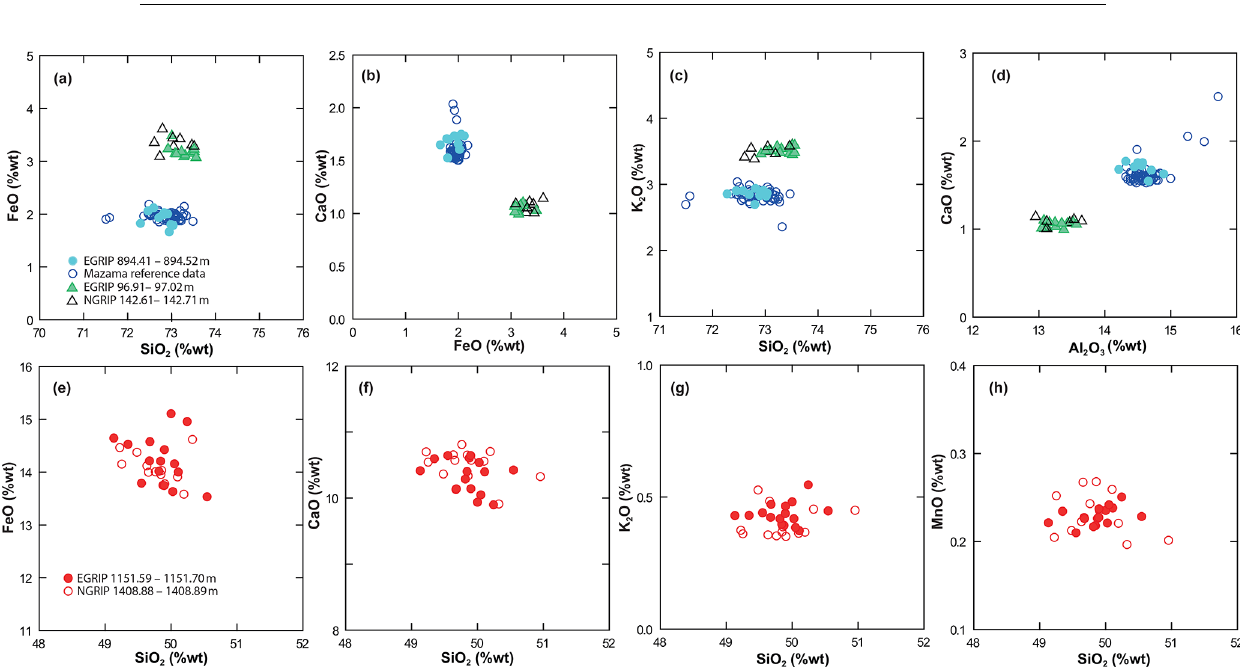
Figure 7. Element–element biplots showing geochemical matches between EGRIP and NGRIP samples with the exception of EGRIP at 894.41–894.52m (EGRIP bag 1627), which is shown here with Mazama data from Jensen et al. (2019). Geochemical data are normalized to 100% (anhydrous basis), and analyses with totals below 94 %wt were excluded. Panels (a–d) are for EGRIP bags 177 and 1627; panels (e–h) are for EGRIP bag